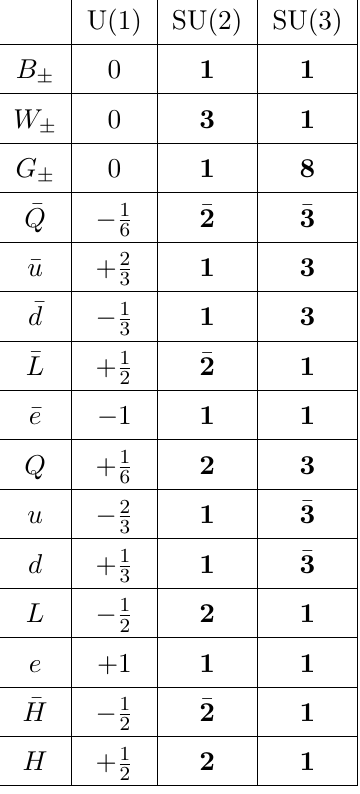
Table 3 . The spectrum of the Standard Model and the transformation properties of all the